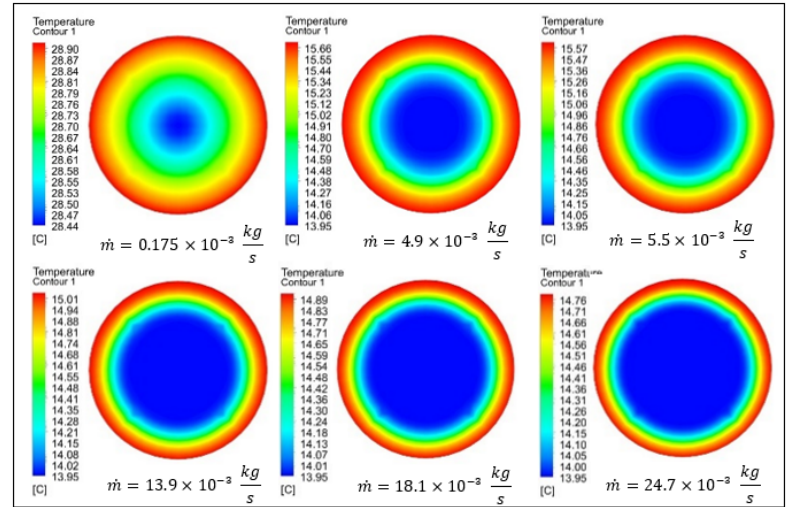
Figure 17. Outlet temperature distribution contours at different mass flow rates.